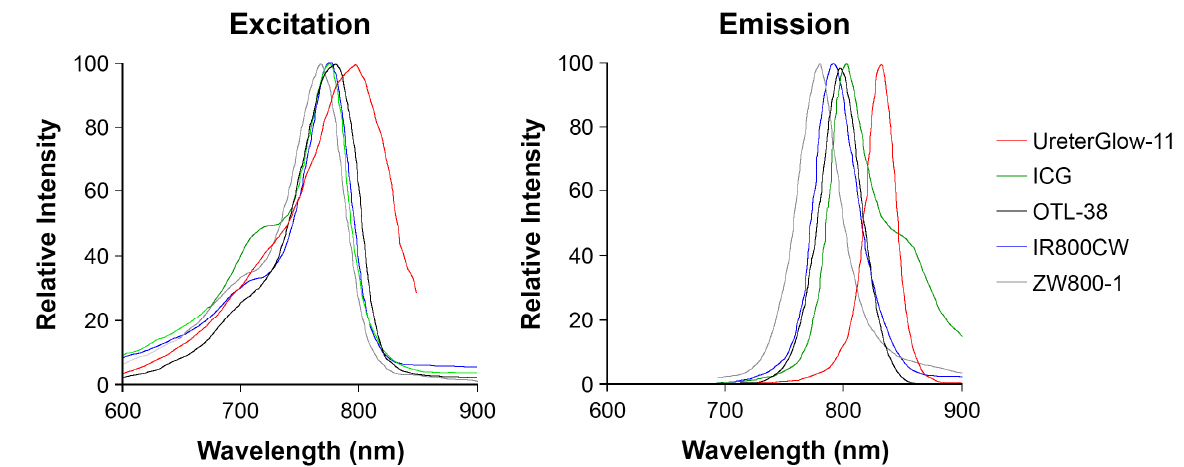
Figure 1. Excitation and emission spectra of various NIR dyes for fluorescence-guided surgery applications. Dyes (1 µ M in PBS, pH 7.4) were excited at 680 nm and their emissions were scanned from 700 to 900 nm. Alternatively, excitation wavelengths were scanned from 600 nm to 850 or 900 nm while the emission wavelength was set at 900 nm followed by normalization of their intensities.